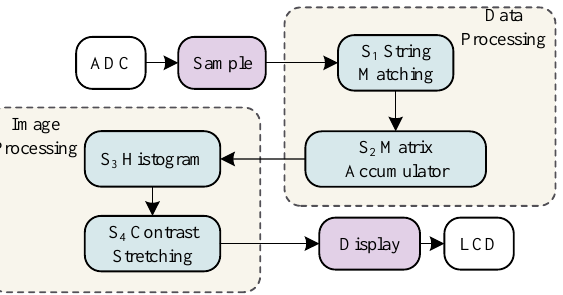
Figure 9. Servants and execution-flows model for 3D waveform oscilloscope.